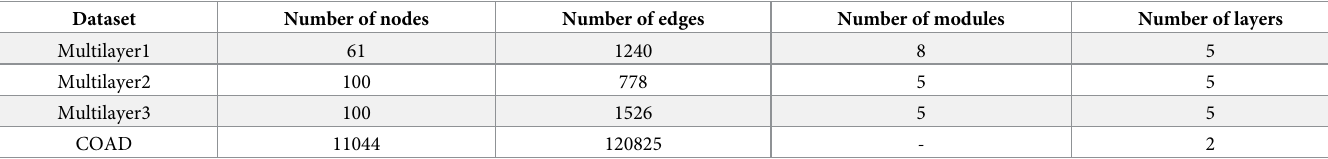
Table 2. Topological properties of multilayer networks employed in the